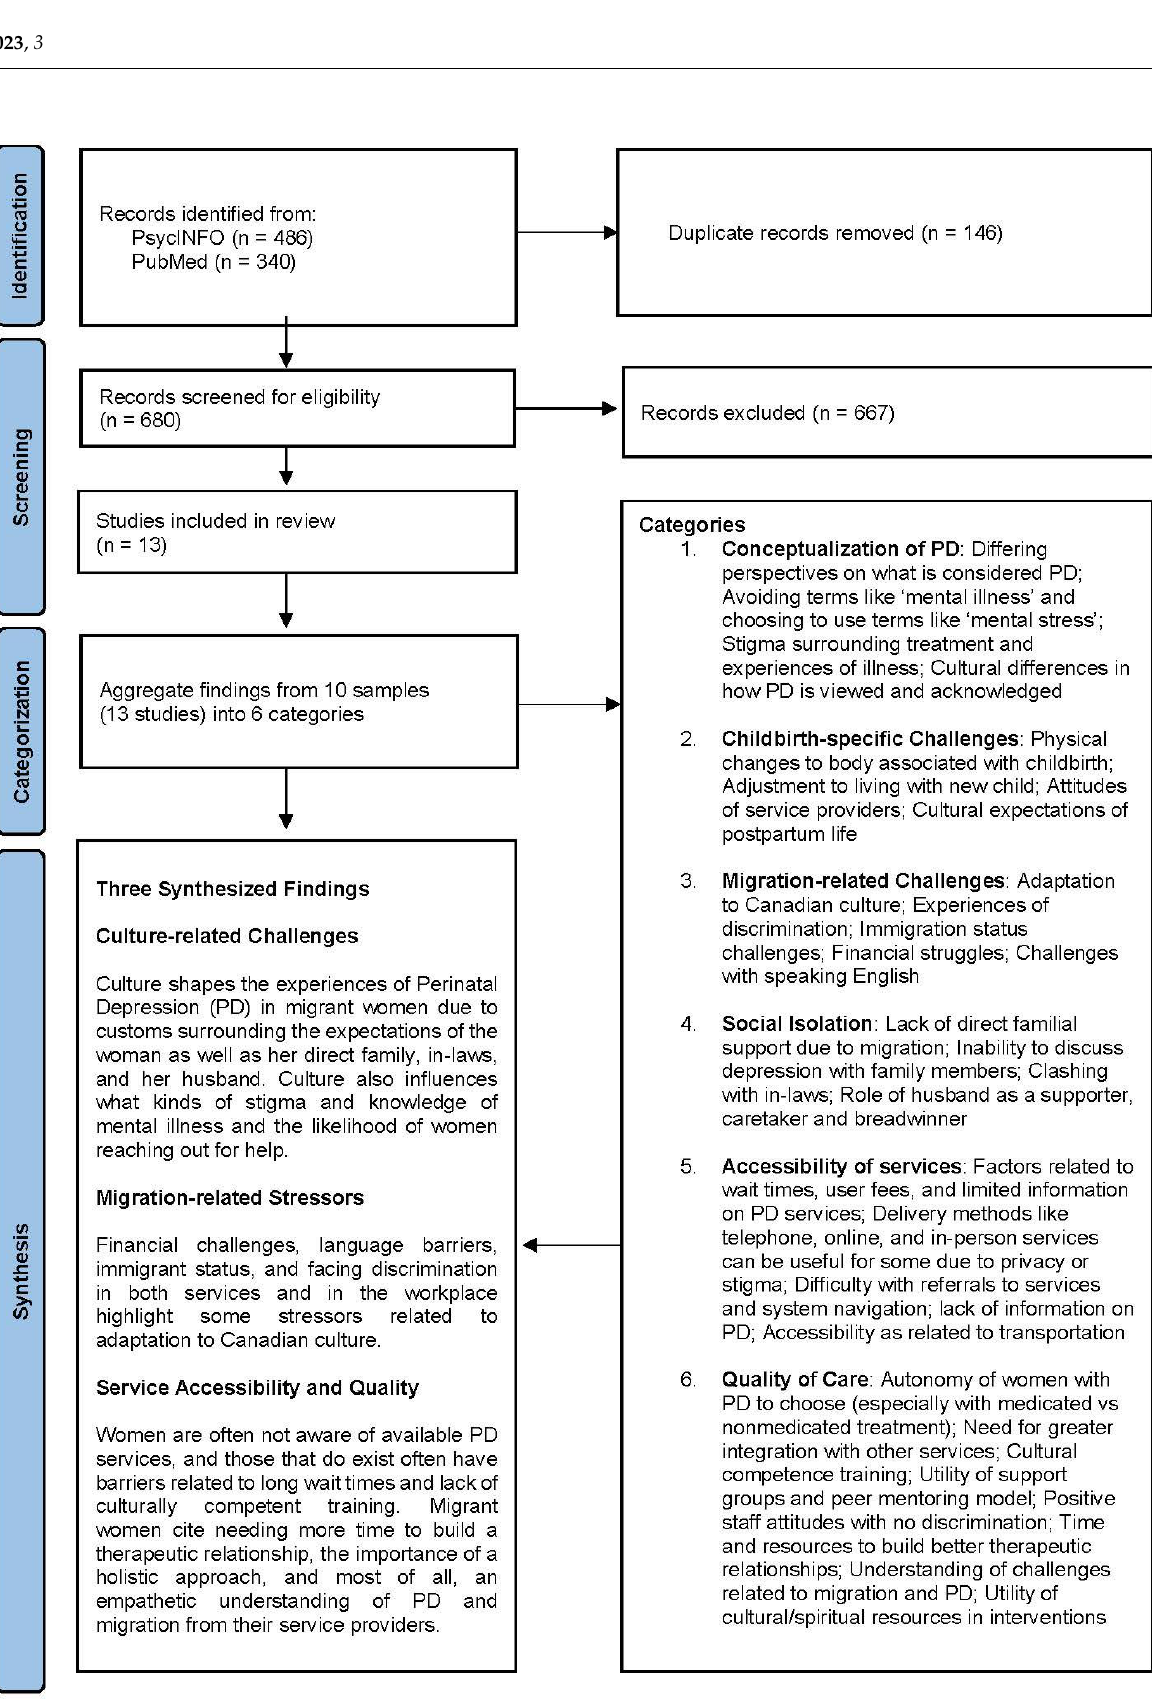
Figure 1. Flowchart for the process of meta-aggregation of qualitative study themes [25,26].